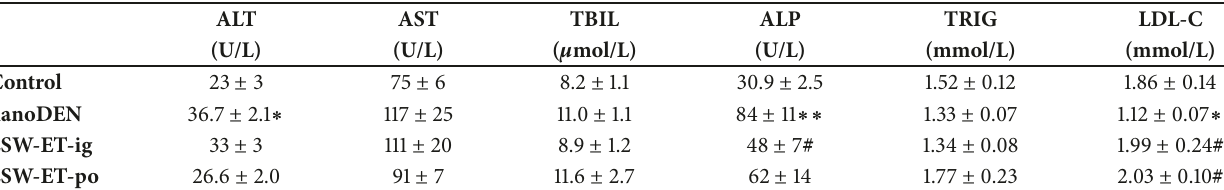
Table 2: Results of the serum chemistry profile analysis in the week 30 mice. The changes in serum ALT, AST, TBIL, and ALP levels directly or indirectly reflect the damage, and the changes in serum TRIG and LDL-C levels reflect the lipid accumulation and metabolism of livers in groups under different treatments. Data were presented as mean ± SEM. Comparing with the control group, ∗ and ∗∗ represent P < 0.05 and 0.01, respectively, while comparing with the nanoDEN group, # represents P < 0.05. ALT A S T T B